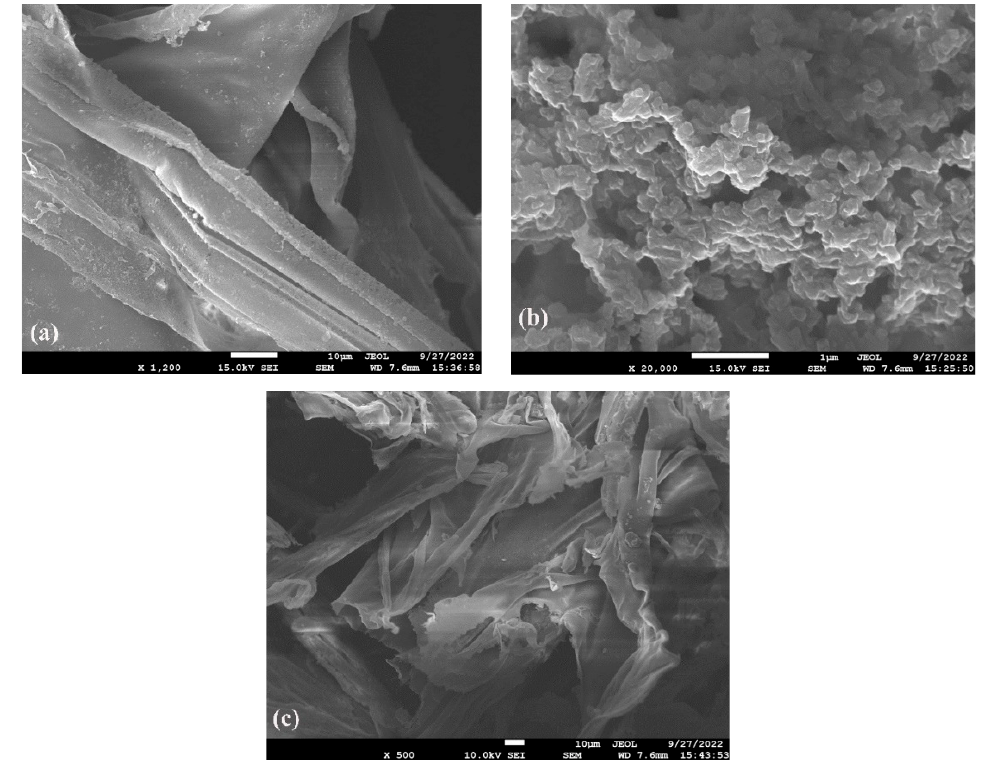
Figure 3. SEM images of ( a ) PLA, ( b ) COF, and ( c ) COF-PLA.